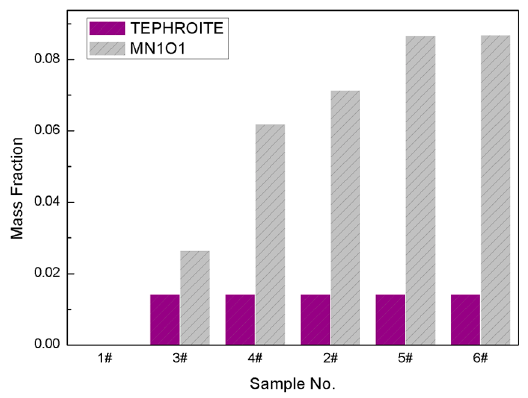
Figure 9. Comparison of the content of oxide on the samples according to thermodynamic calculation.